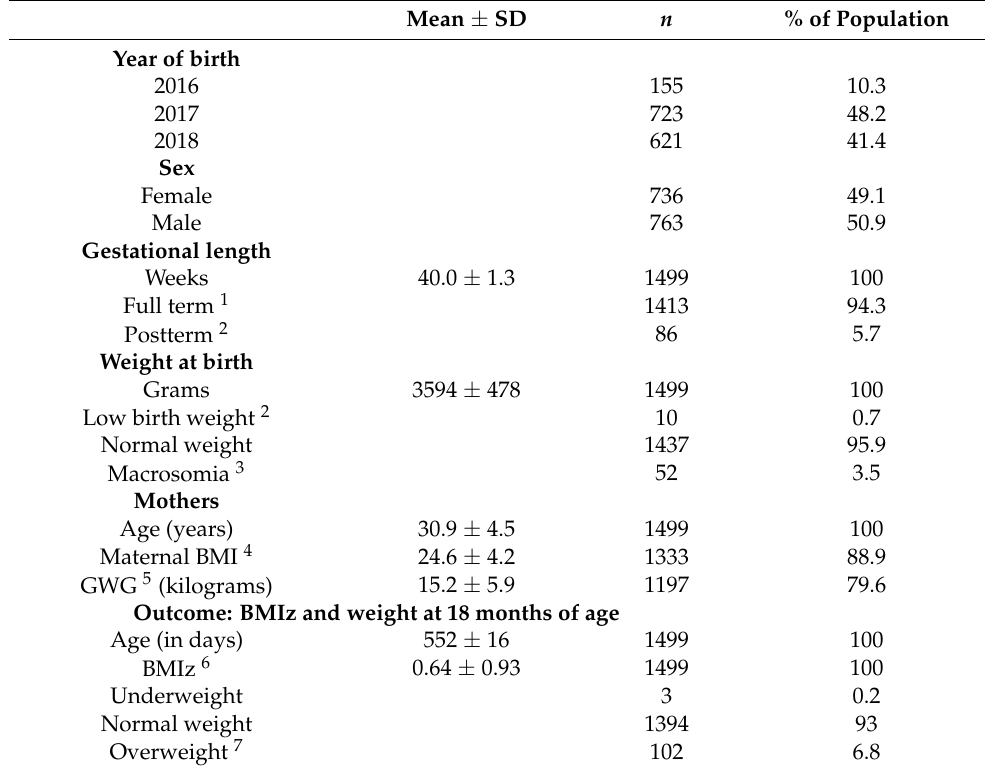
Table 1. Characteristics of the participating children and mothers.